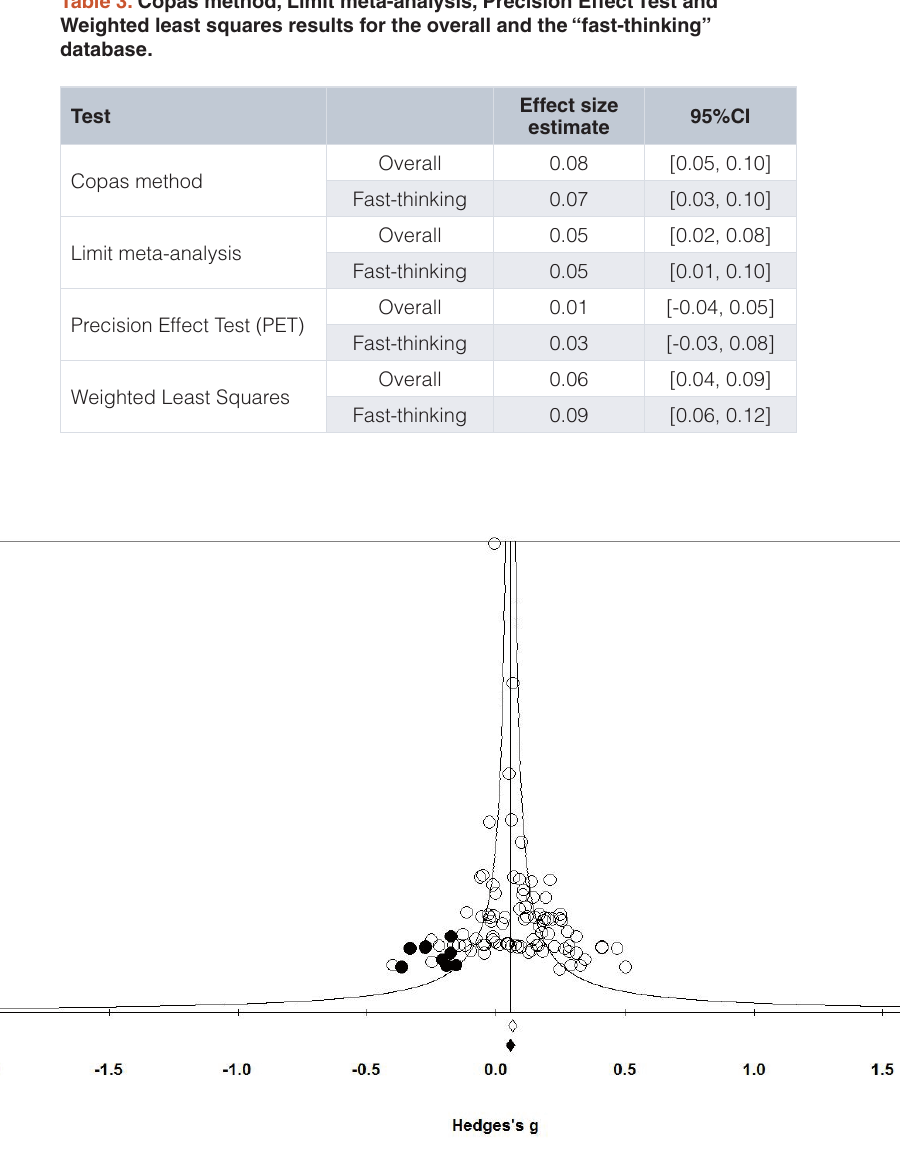
Figure 1. Funnel Plot of the observed studies (white circles) and the imputed missing studies (black circles) under a random-effects